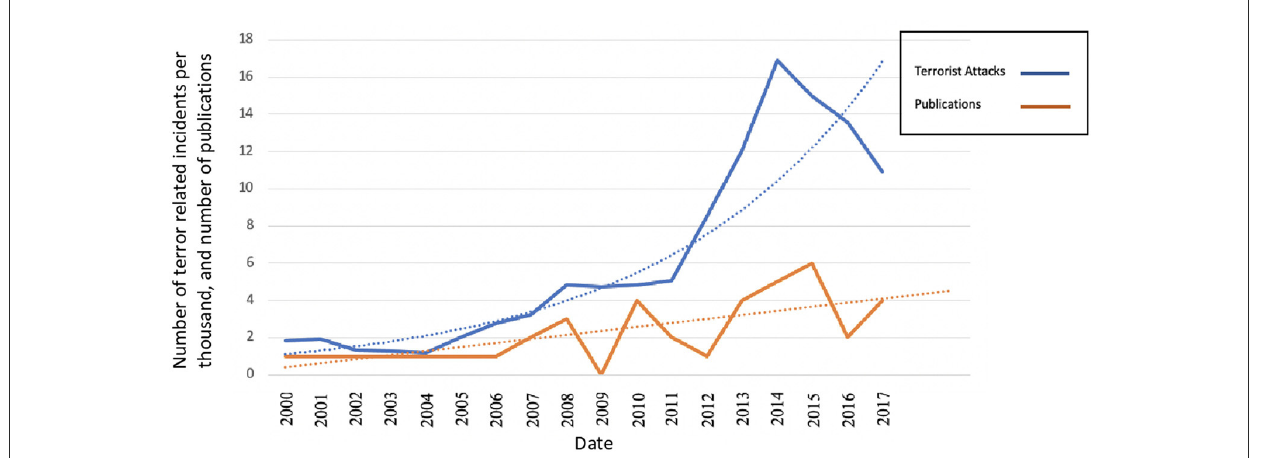
FIGURE3 A forecast plot, showing the total number of global terror related incidents (per thousand) and number of published studies between 2000 and 2017. The forecast suggests that as terror related incidents grow exponentially, the number of published studies increase by a factor of 20%. This is not proportionate to the prevalence of critical incidents and suggests that there is a need for greater emphasis on research.